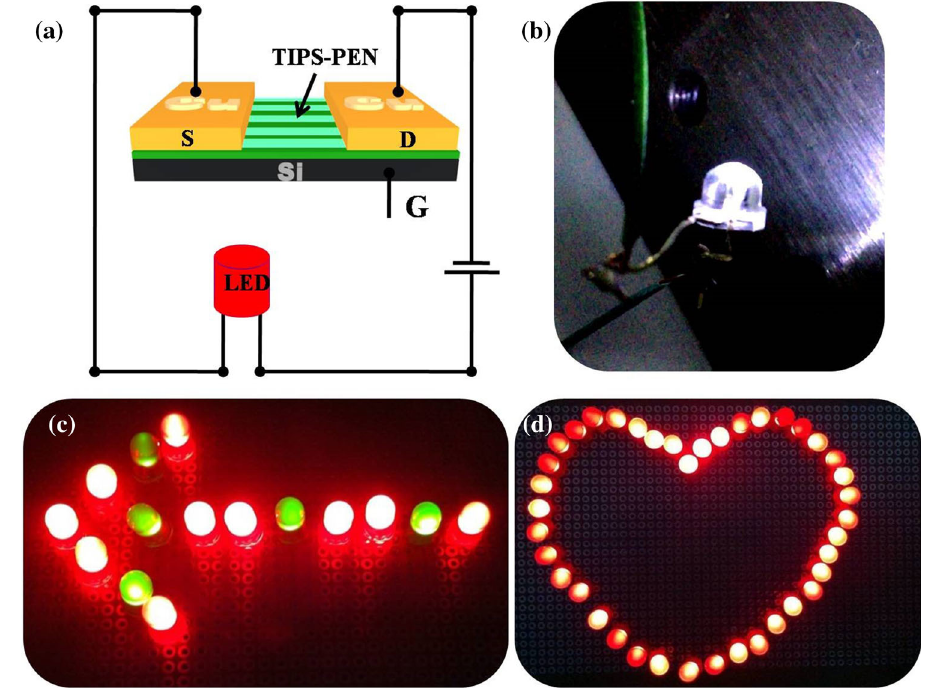
Fig. 7 a Circuit schematic of the ribbon array-based OFET-LED system. b Photograph of one LED driven by the OFET based on TIPS-PEN ribbon arrays. c , d Show the photographs of the LED pixels driven by the OFET based on TIPS-PEN ribbon